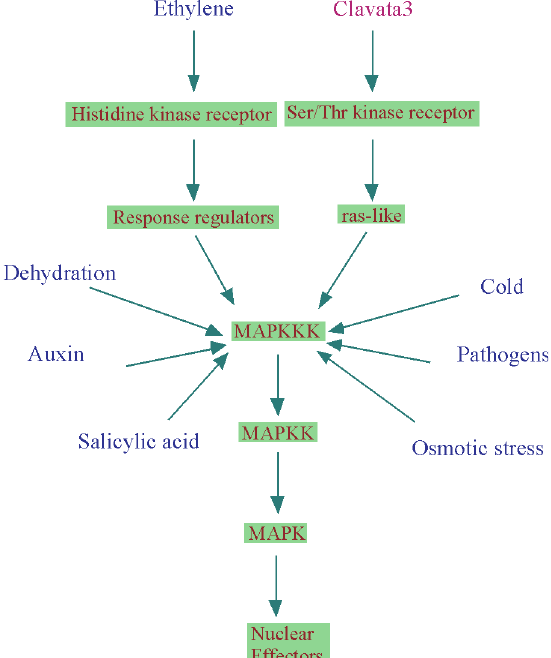
Figure 3 - Signals mediated by the MAP kinase module. The dashed lines represent undefined pathways. The components for which clusters have been found in sugarcane are highlighted in